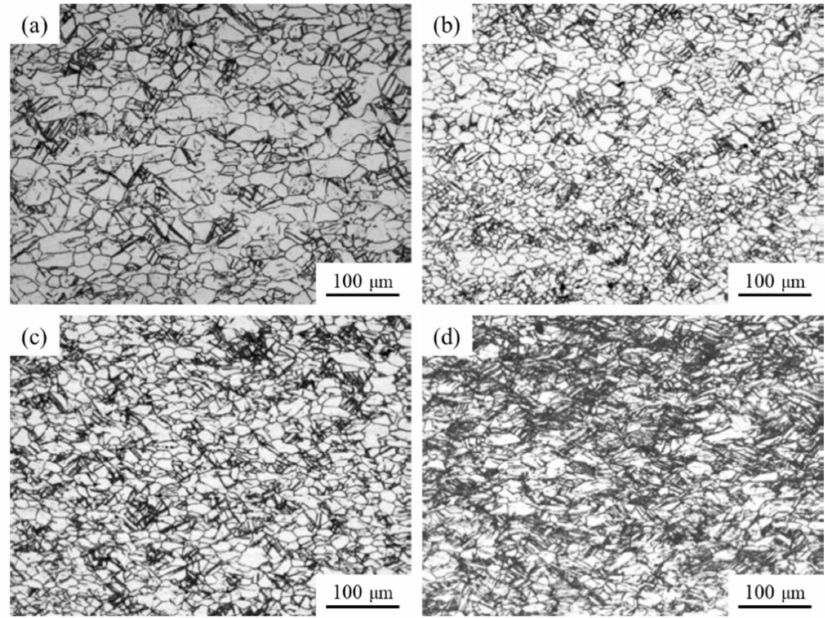
Figure 3. Microstructure of the four plates after the 2nd rolling process at 300 ◦ C: ( a ) plate A; ( b ) plate B; ( c ) plate C; and ( d ) plate